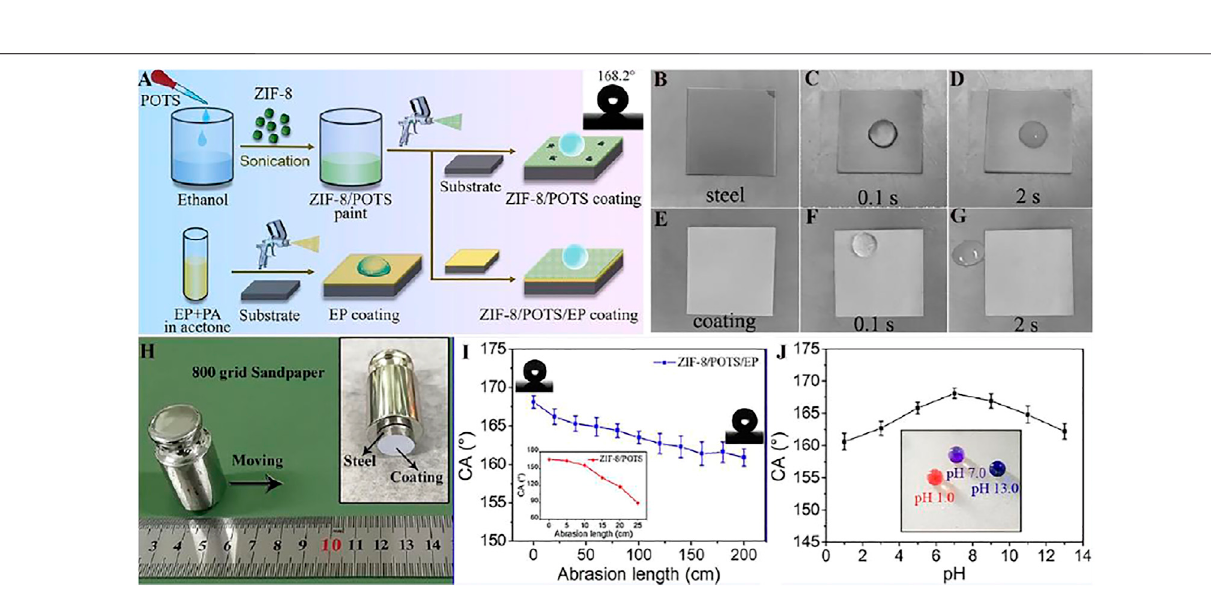
Frontiers in Bioengineering and Biotechnology |